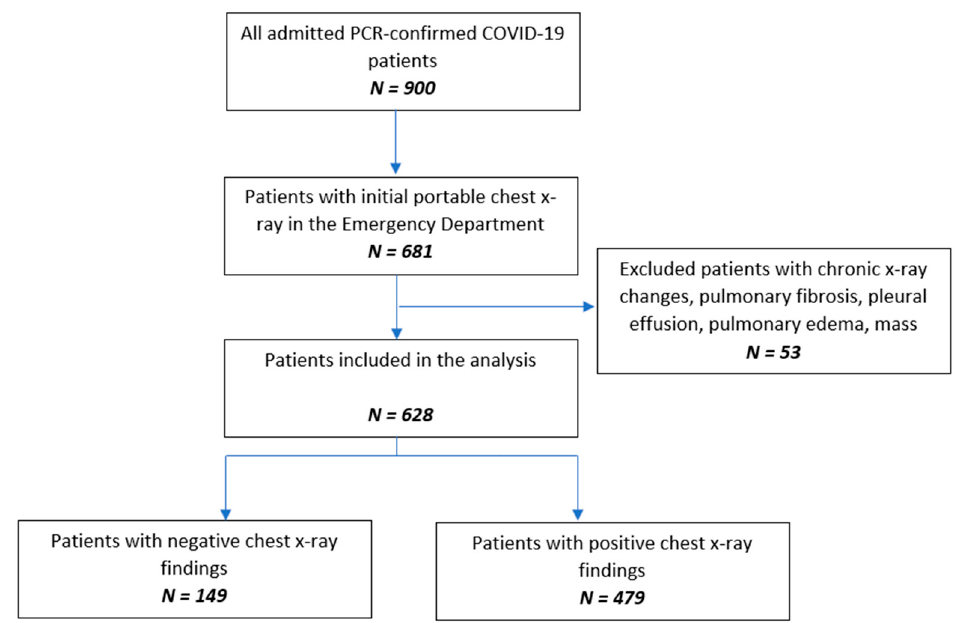
Figure 1. Flow chart of the study population.